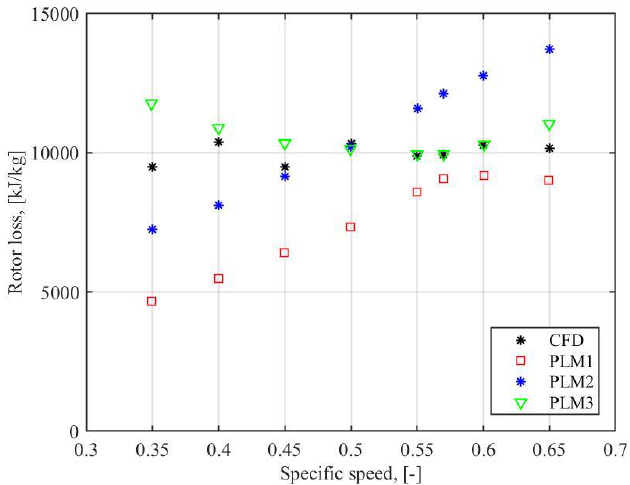
Figure 5. The comparison of CFD results and the results of different passage loss models of rotor losses including the passage loss, clearance loss and the incidence